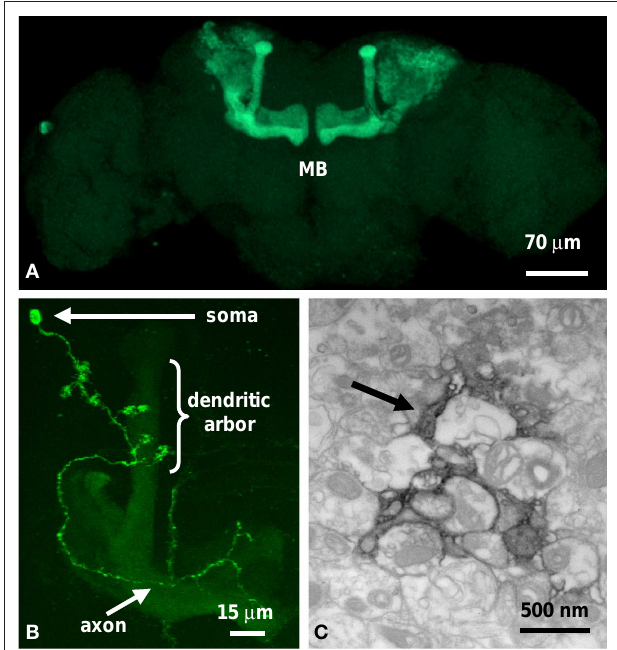
FIGURE 2 | Imaging the mushroom body learning and memory center. (A) OK107-GAL4 line driving GFP in the Mushroom Body (MB). (B) A single MB neuron clone generated by MARCM. (C) The MARCM fl uorescent signal photoconverted to an electron-dense signal in the presence of diaminobenzene (DAB) with high intensity 490 nm light. The arrow points to a labeled MB